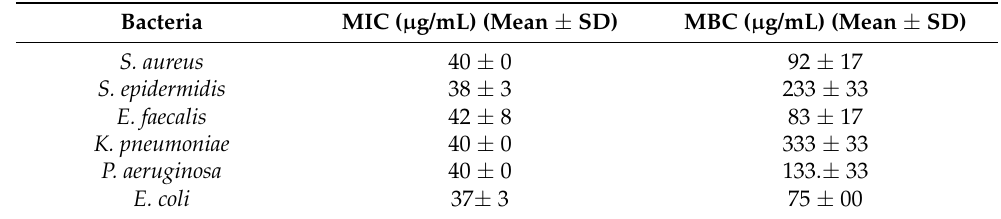
Figure 9. Resazurin Plate assay showing the MIC values of the UD-AgNPs against S. aureus , E. faecalis , S. epidermidis , E. coli , K. pneumoniae , and P. aeruginosa . Table 2. Minimum inhibitory concentrations (MICs) and minimum bactericidal concentration (MBC) of UD-AgNPs against Gram-positive and Gram-negative